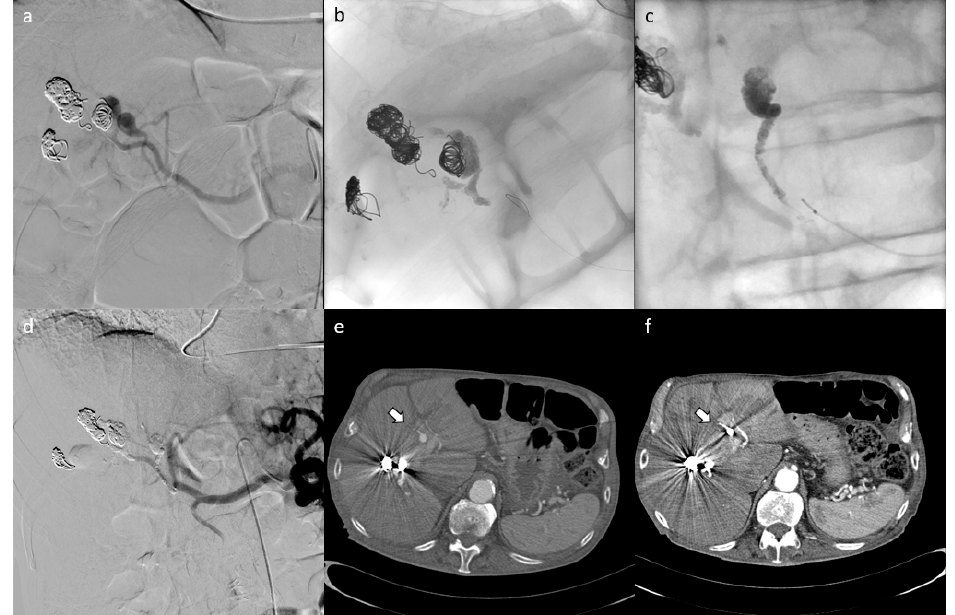
Figure 2. Patient with multiple post-pancreatitis hepatic pseudoaneurysms who had undergone previous embolization with metal coils and who presented with new hemoglobin drop underwent CT scan, demonstrating the presence of new pseudoaneurysms. ( e ) shows the pre-procedural CT scan with pseudoaneurysms and the results of the embolization with metal coils. The patient underwent embolization of the pseudoaneurysms (( a ) shows pre-embolization angiography; ( b – d ) show outcomes of embolization and completion angiography). Post-procedural CT scan demonstrates the correct embolization of the pseudoaneurysms in the absence of non-target embolization ( f ). All patients underwent pre-treatment evaluation with CT-angiography (CTA) and/or MR-angiography